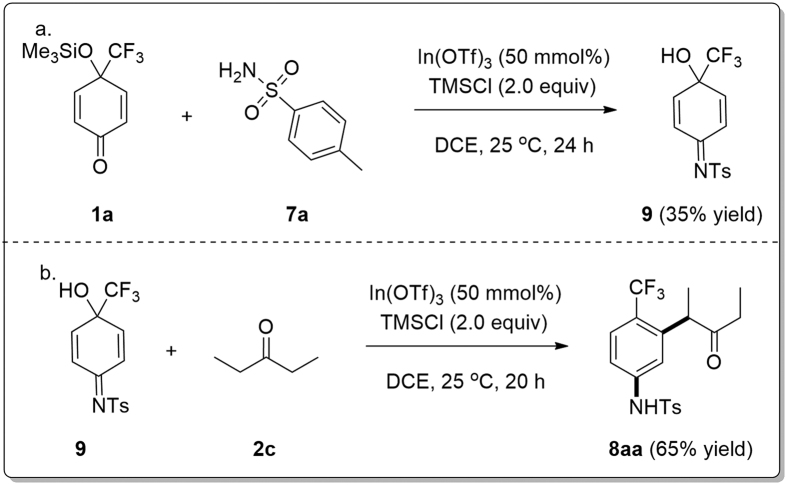
Mechanism studies.